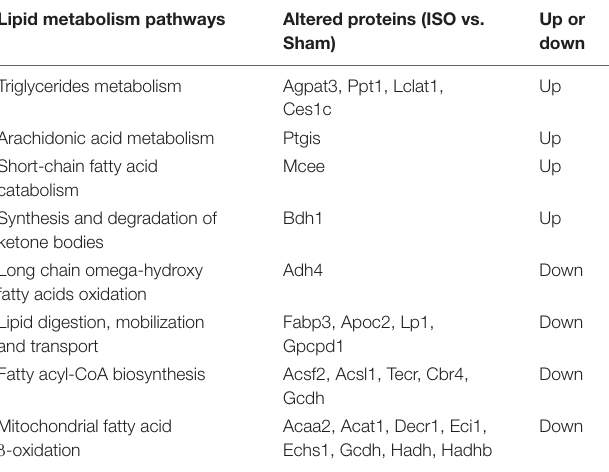
TABLE 2 | The altered proteins enriched in lipid metabolism pathways evoked by ISO. Lipid metabolism pathways Altered proteins (ISO vs.